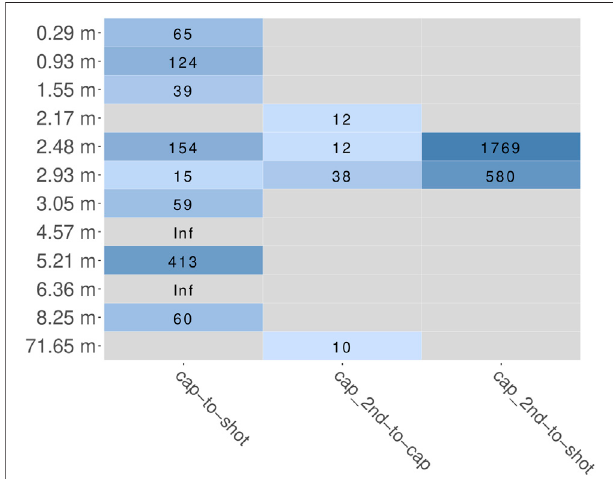
FIGURE 6 | Fold change of relative abundance of marker reads ( cox1 and rbcL summarized) estimated by HMMs. Coloration according to log10 value of fold change. Grey panels indicate inability to calculate fold change, either because of a zero delimiter ( “ Inf ” ) or missing data (because a sample was not included in the respective experiment). “ cap ” , fi rst round capture data; “ shot ” , shotgun data; “ cap_2nd ” , second round capture data.